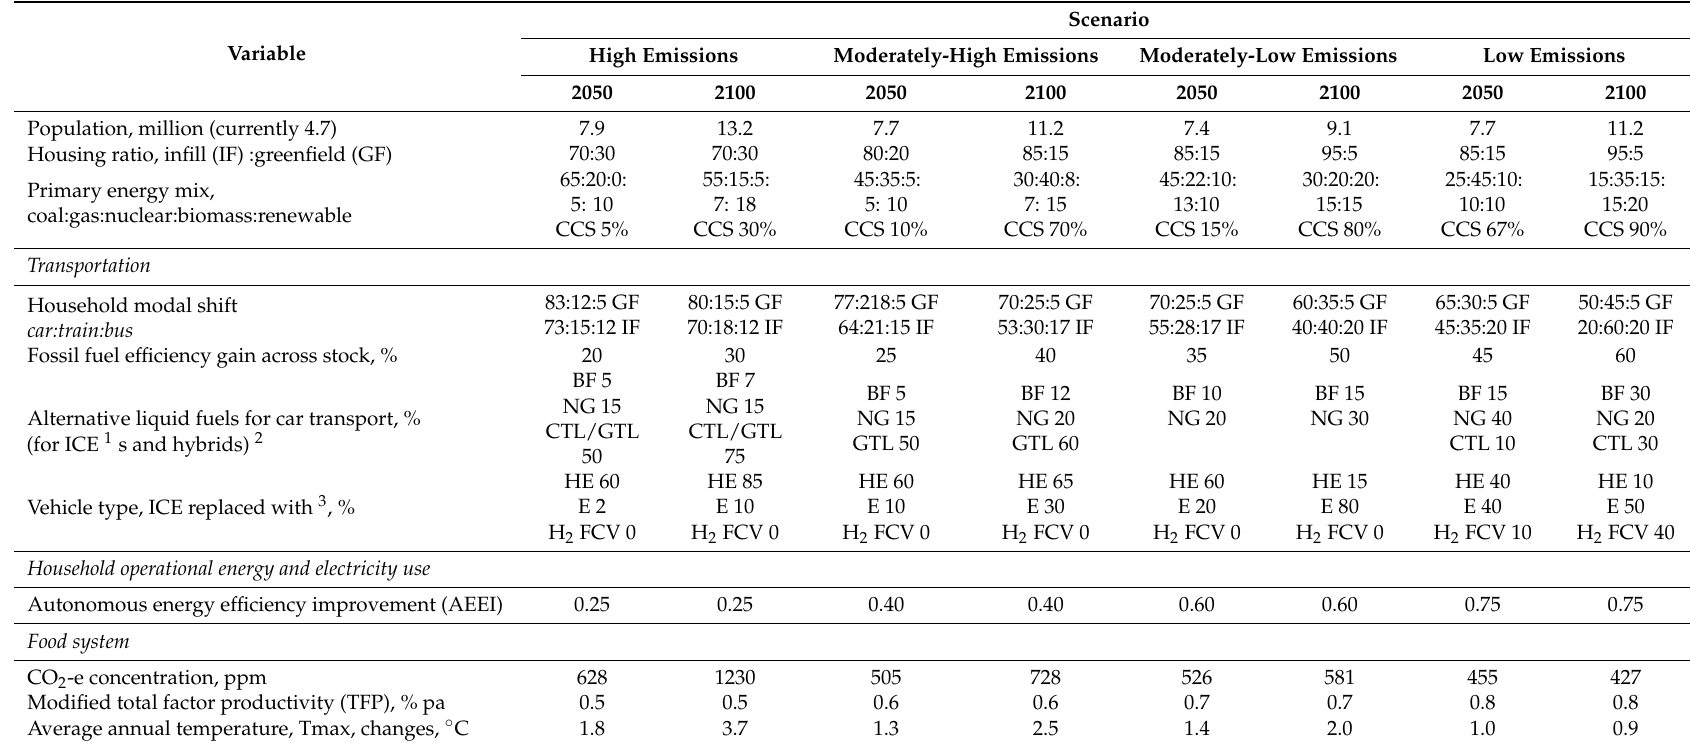
Table 3. Quantification of explanatory